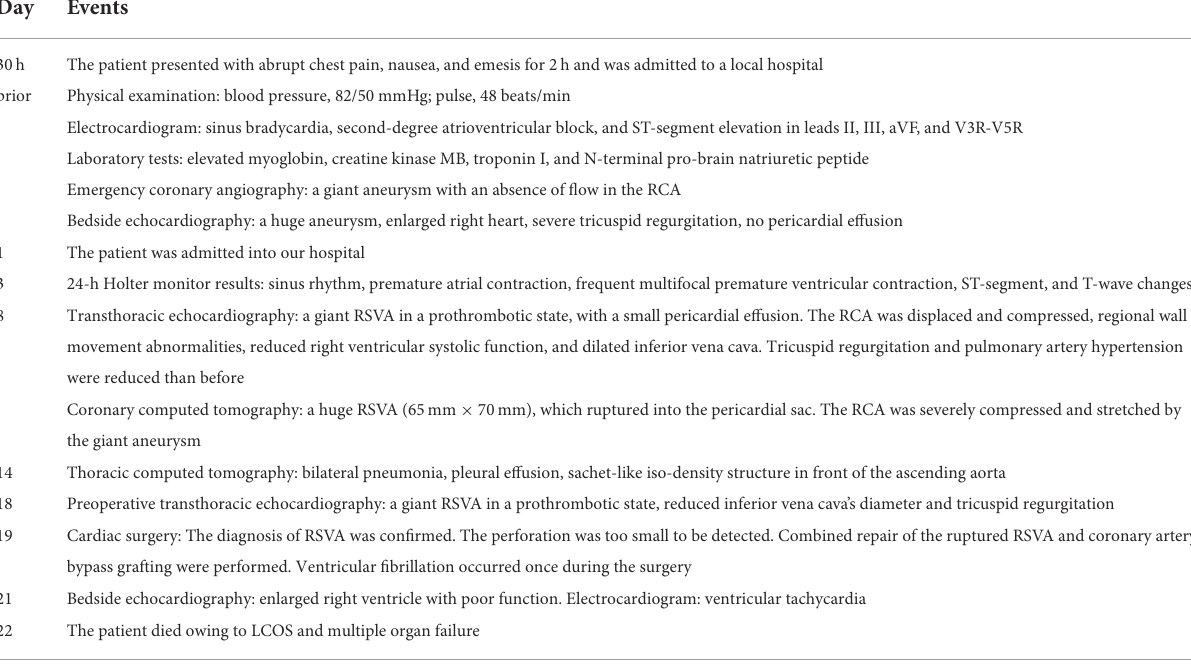
TABLE 1 The patient’s admission timeline, diagnosis, and